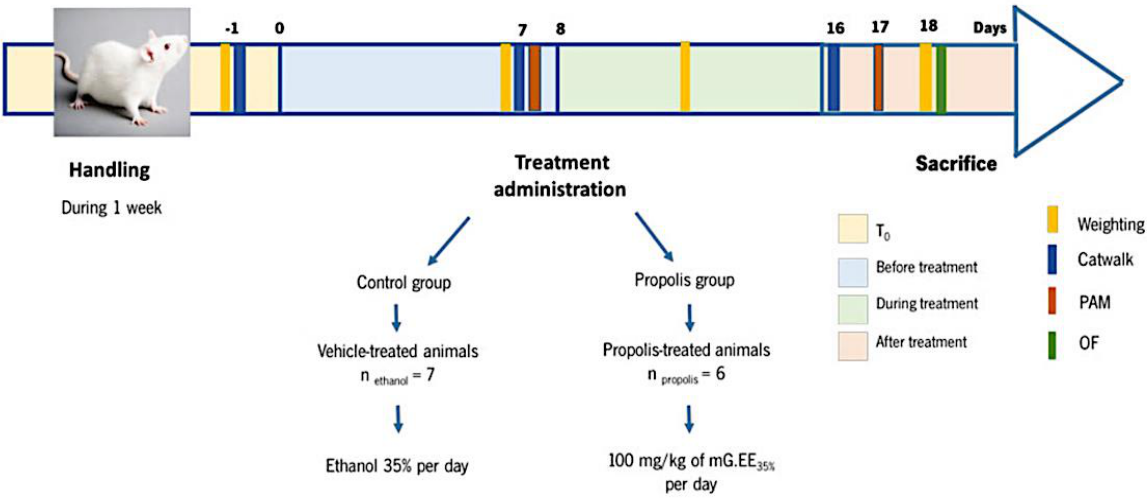
Figure 1. Schematic Representation of the Experimental Design. One week before OA induction with the Kaolin-Carrageenan-Induced Arthritis model, animals were handled daily to habituate to the experiment room conditions and the surroundings. Animals’ weight was assessed every Monday as an indirect indicator of health status. Propolis administration started one week after OA induction (T 0 ) and was accomplished for one week (T 8 –T 18 ). PAM was performed one week after OA induction (before treatment) and 10 days after propolis administration (after treatment). The catwalk was conducted one day before the OA induction (T 0 ), one week after OA induction (before treatment), and, lastly, one week after propolis administration (after treatment). The Open Field (OF) test was performed at the end of the experiments before the animals were